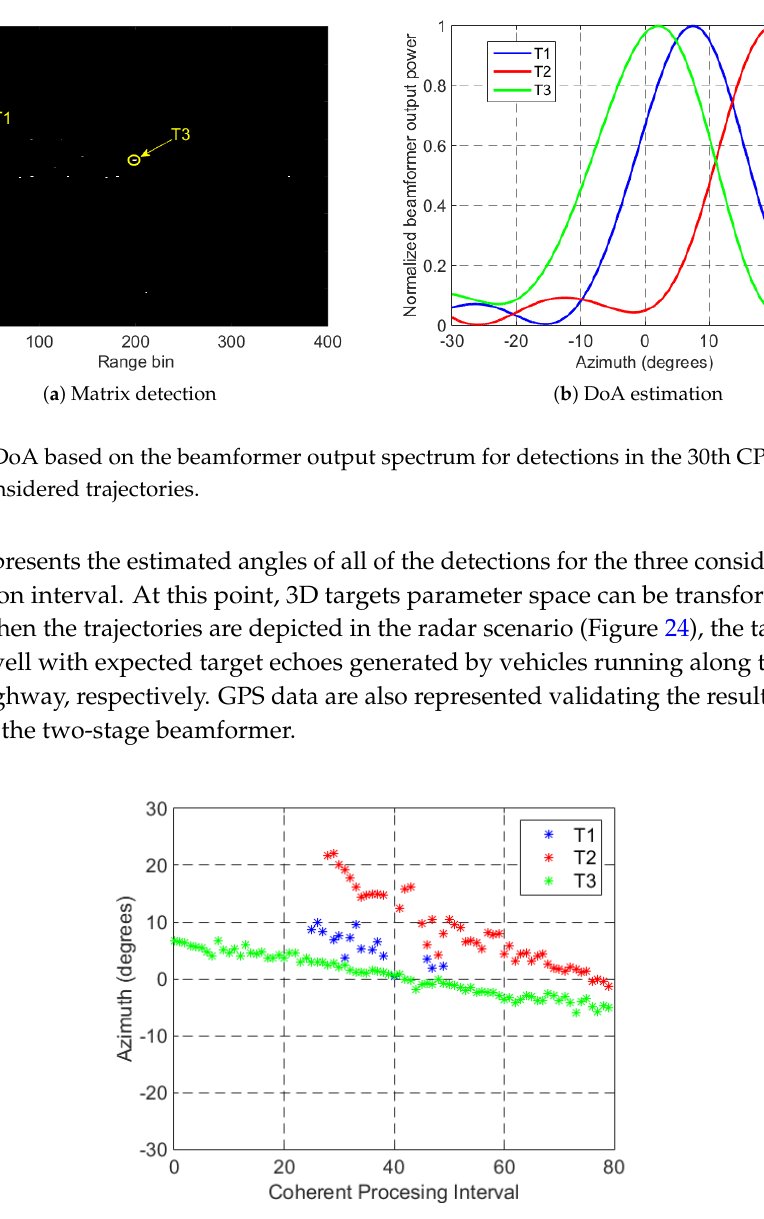
Figure 23. DoA based on the beamformer output spectrum for targets T 1, T 2 and T 3.